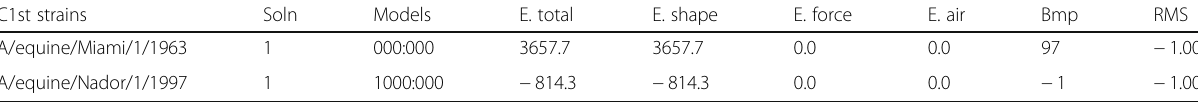
Table 1 Result of docking protein-protein from Hex 8.0 software (http://hex.loria.fr/) C1st strains